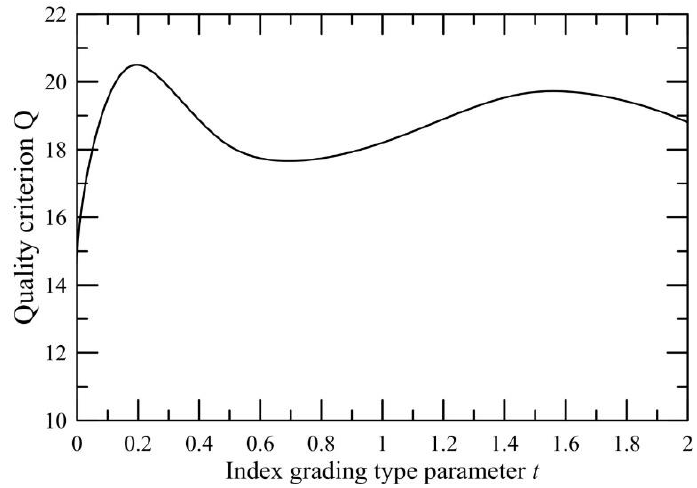
Figure 6. Quality criterion as a function of the index grading type parameter for the cylindrical graded-index lens.